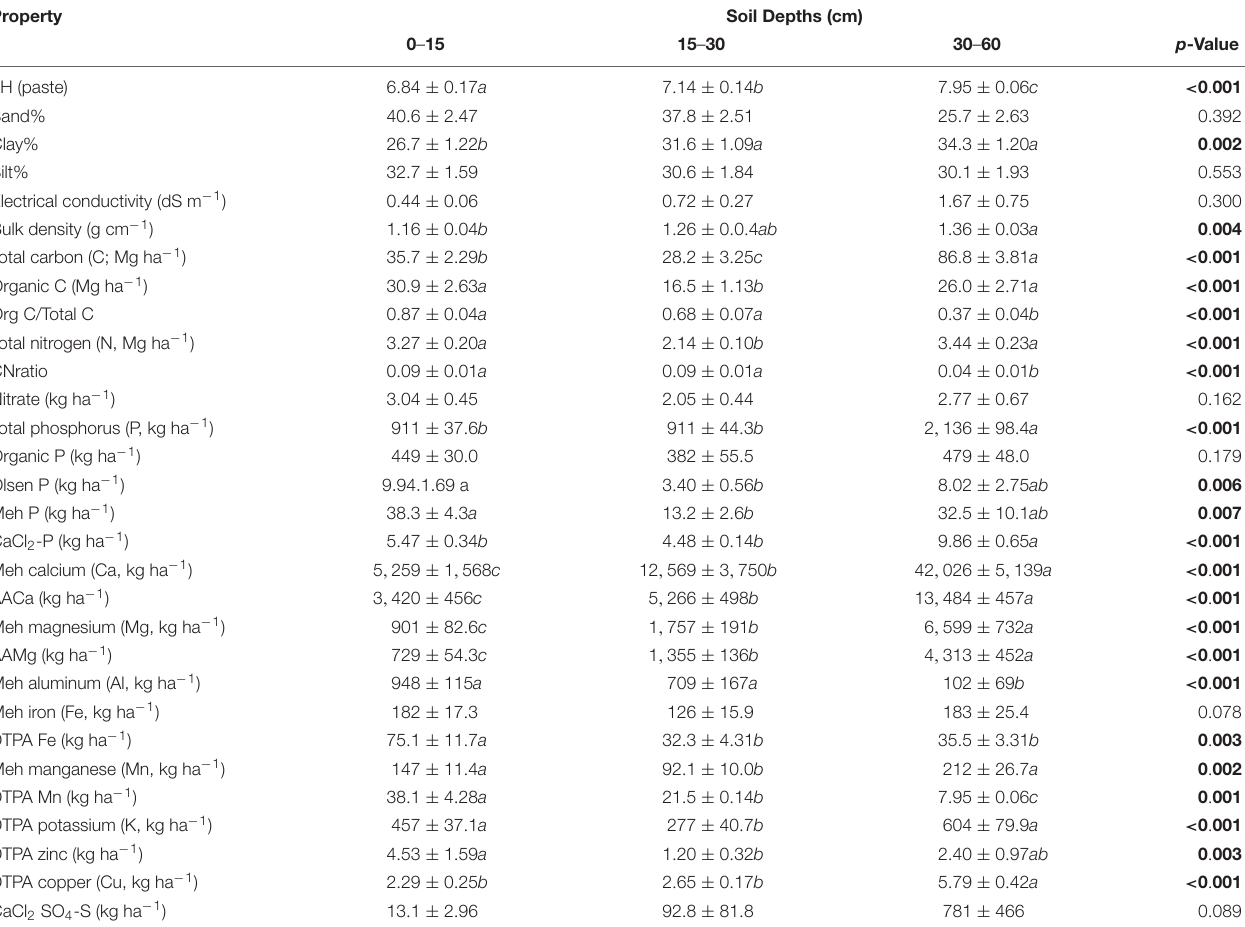
TABLE 3 | Soil chemical data by depth. Values are means ± std. err. ( n = 15).